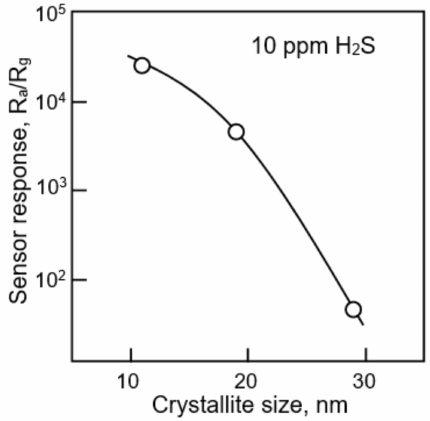
Figure 15. Conductometric response of CuO-SnO 2 composite nanofibers with crystallites of different sizes to 10 ppm H 2 S gas. Adapted from